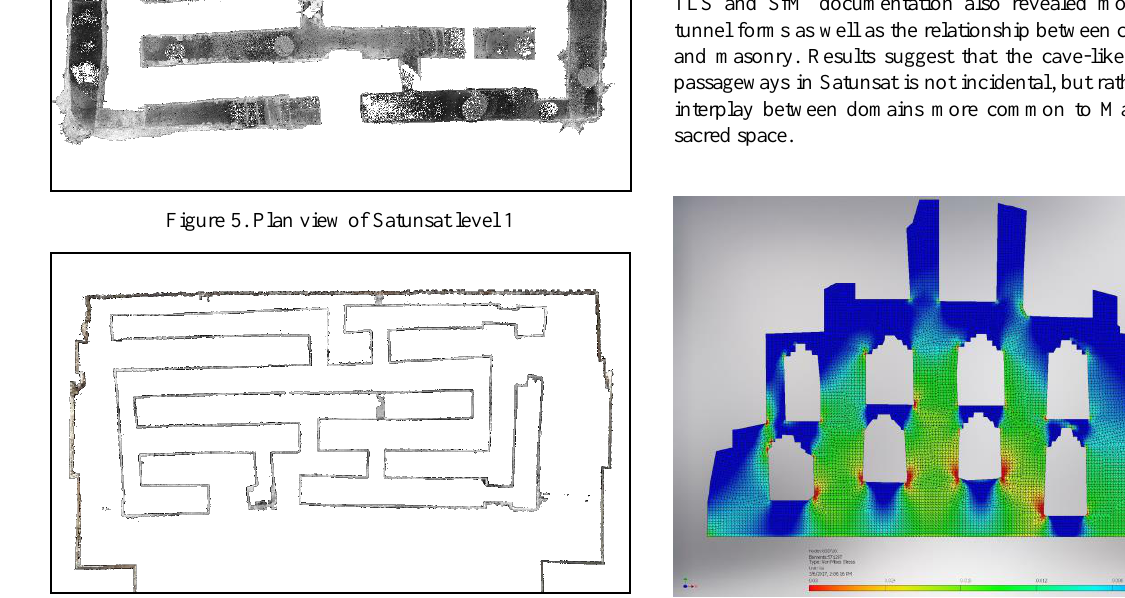
Figure 6. Plan view of Satunsat level 2 Figure 7. Preliminary gravity load stress